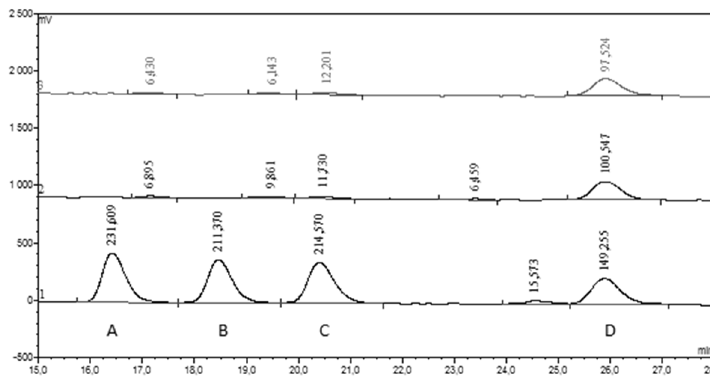
Figure 1. Chromatogram high-performance liquid chromatography, with electrochemical detection (HPLC-ECD). Double chromatographic analysis (HPLC-ECD) of cerebrospinal fluid sample obtained from patient No 9 (Supplementary Materials Table S5). The bottom chromatogram illustrates the elution of standards: A—dihydrocaffeic acid, B—vanillic acid, C—caffeic acid, D—homovanillic acid. Numbers over the peaks represent their area.